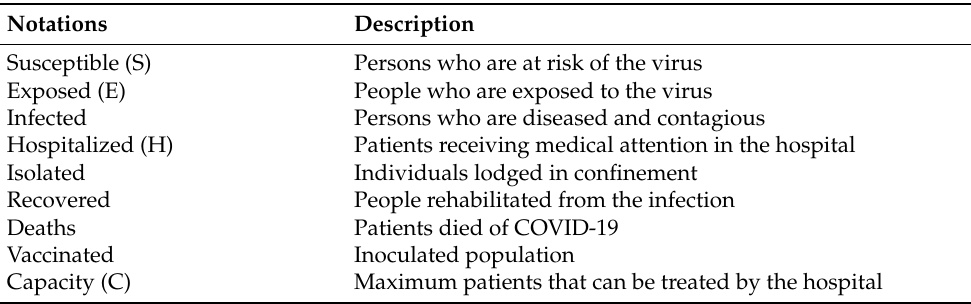
Figure 1. SEIHI s RS pandemic model for COVID-19 [35]. Table 1. Symbols used in the SEIHI s RS